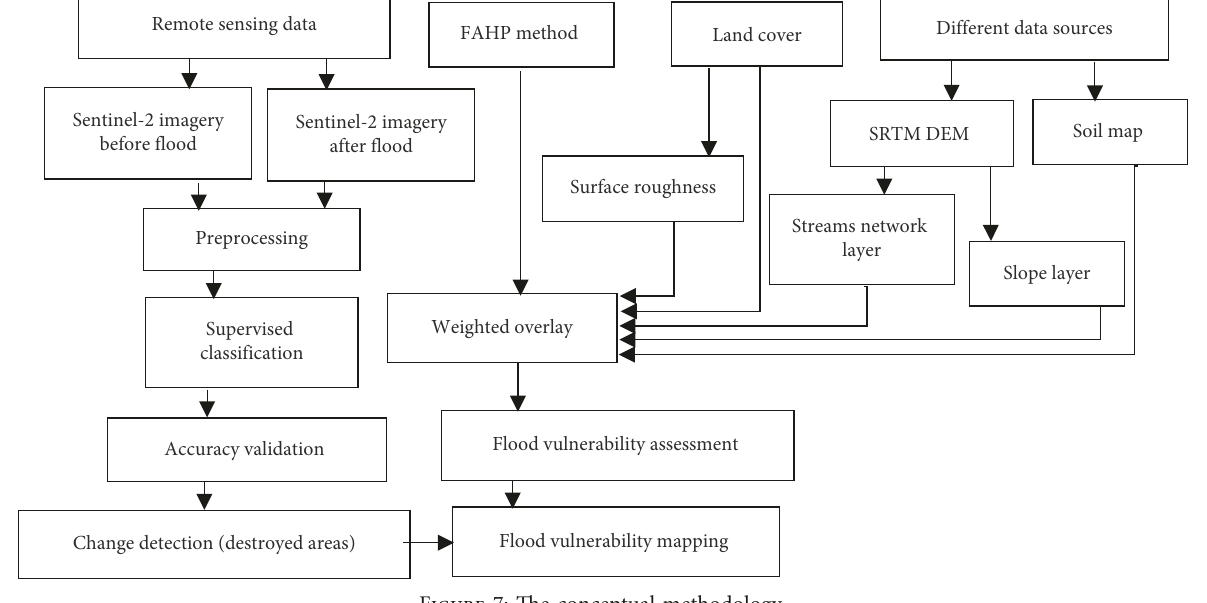
Figure 7: The conceptual methodology.